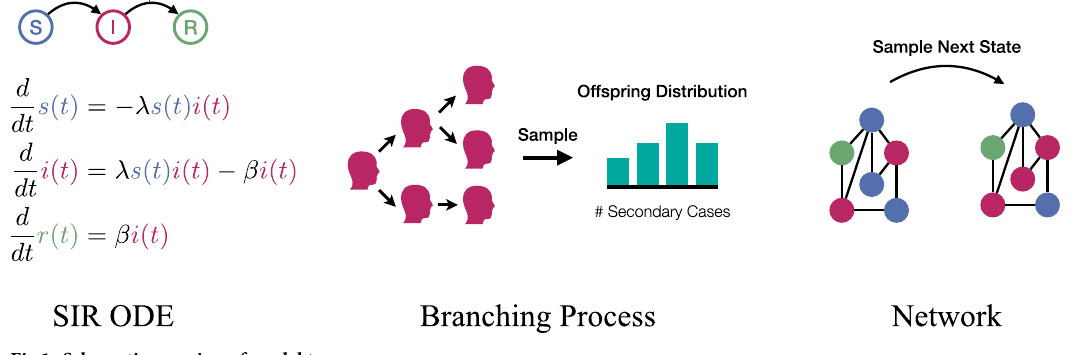
Fig 1. Schematic overview of model